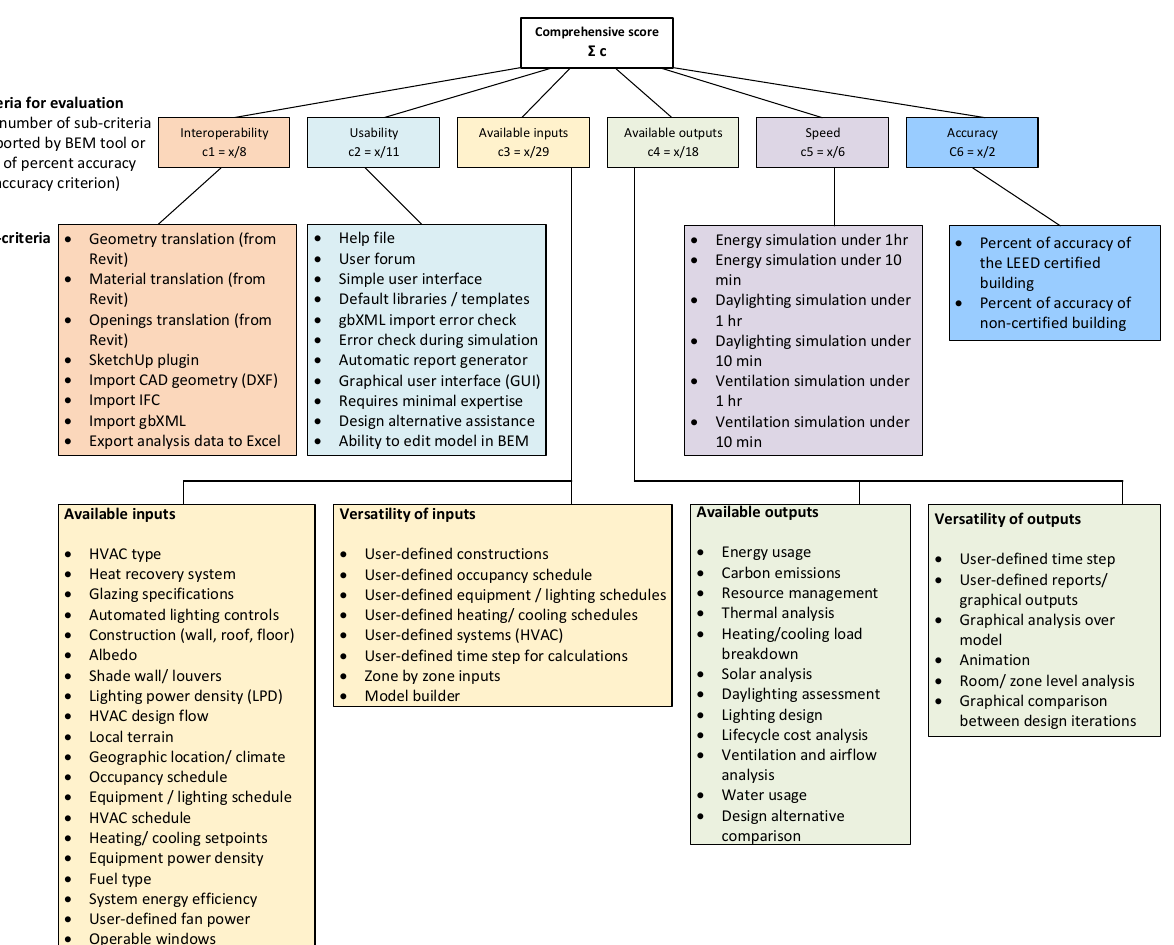
Figure 2. Re-evaluation scoring system with criteria and